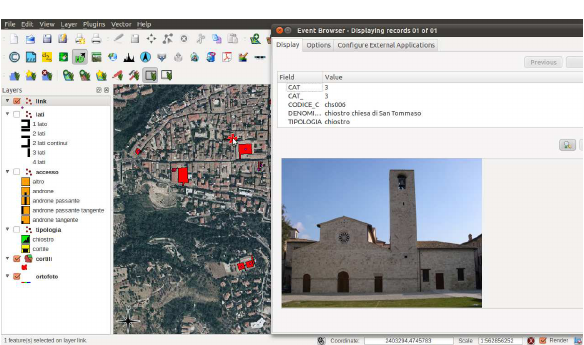
Figure 4. Courtyards and cloisters on the map